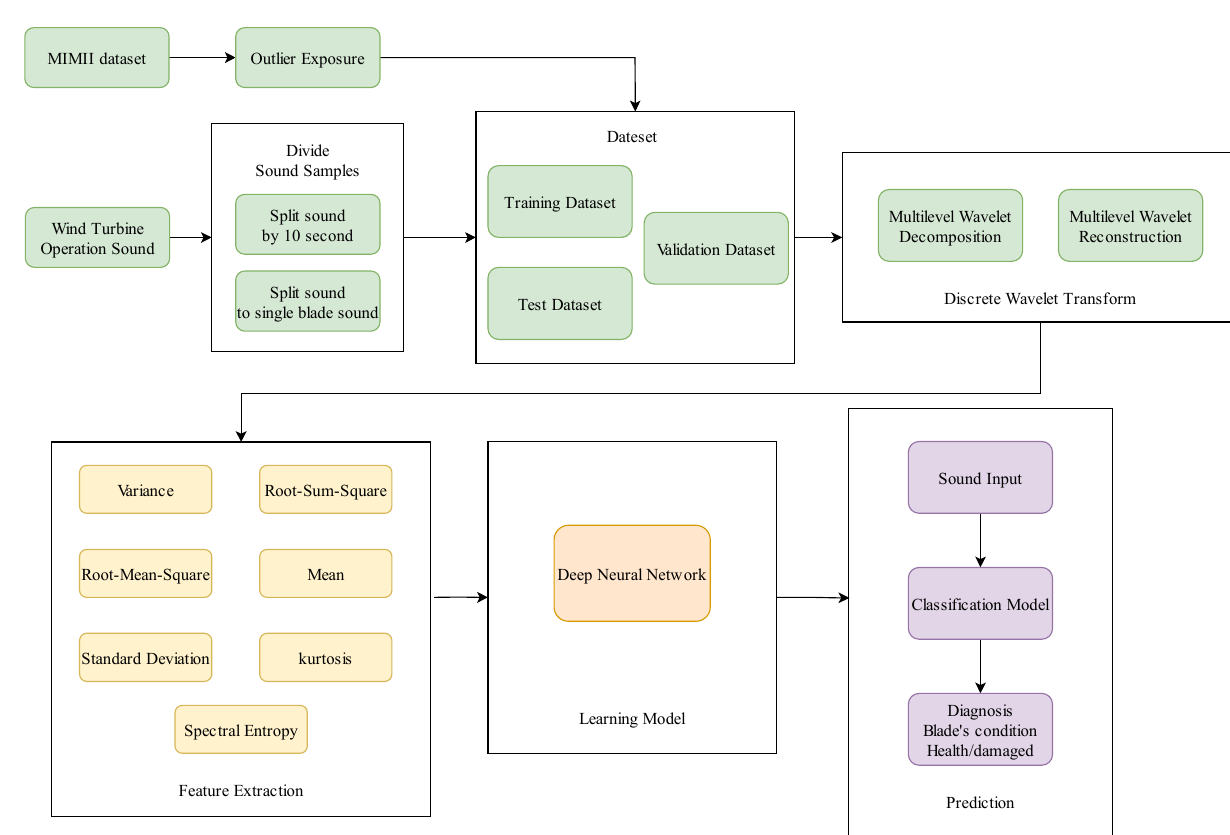
Figure 2. Monitoring model architecture.